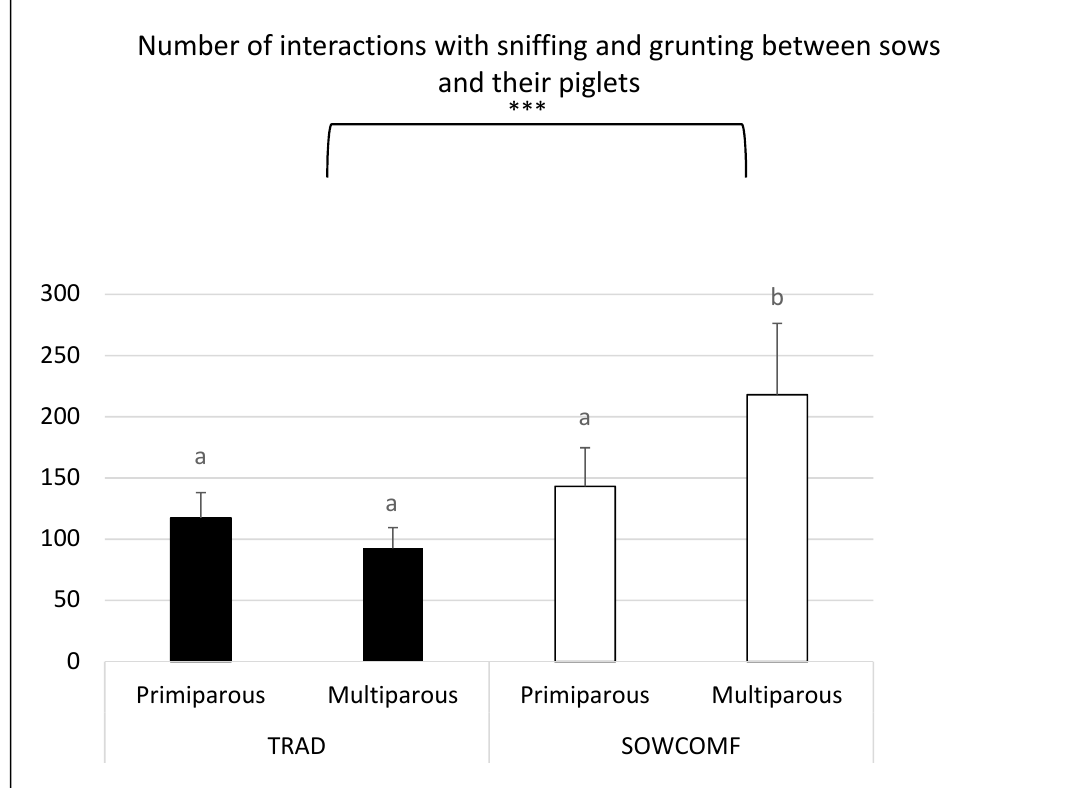
Figure 8. Mean + SE number of interactions with grunting and sniffing between sows and their piglets initiated by the sow approaching the piglets in the period from the onset of farrowing until 12 h post-partum. *** over the bracket : p < 0.0001: significant difference between the traditional pen type (TRAD: n = 10 sows) and the SowComfort (SOWCOMF: n = 12 sows) pen. Superscript letters ab: p < 0.000 , denotes differences between primiparous and multiparous sows within the two pen types.